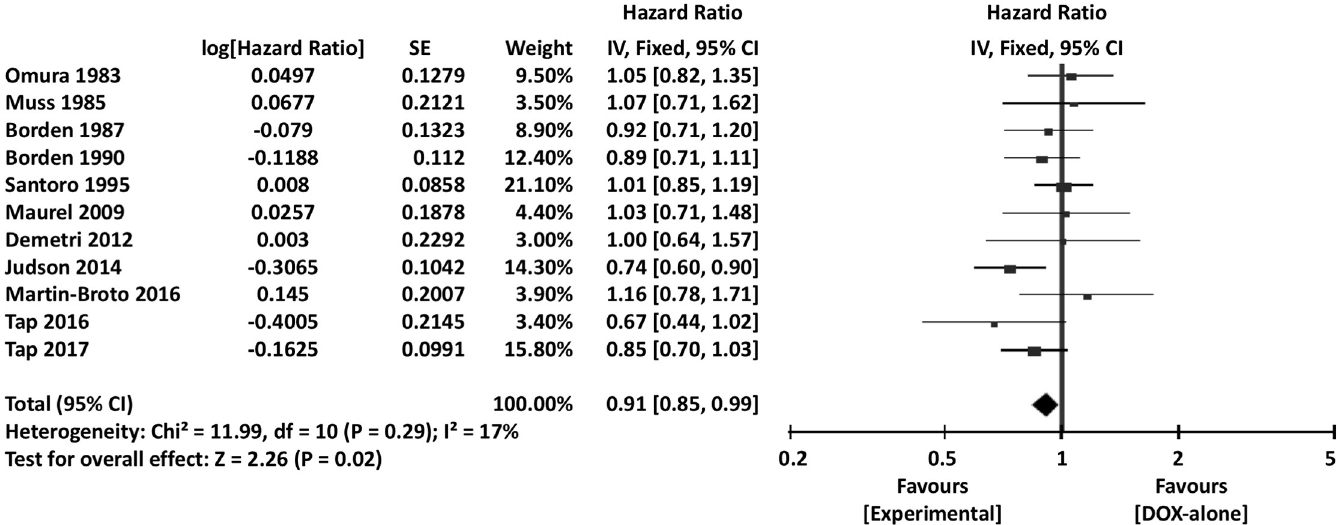
Fig 10. Comparisons of doxorubicin alone vs doxorubicin-based combination chemotherapy: Forest plots of progression-free survival. SE, standard error; IV, inverse variance; CI, confidence interval.